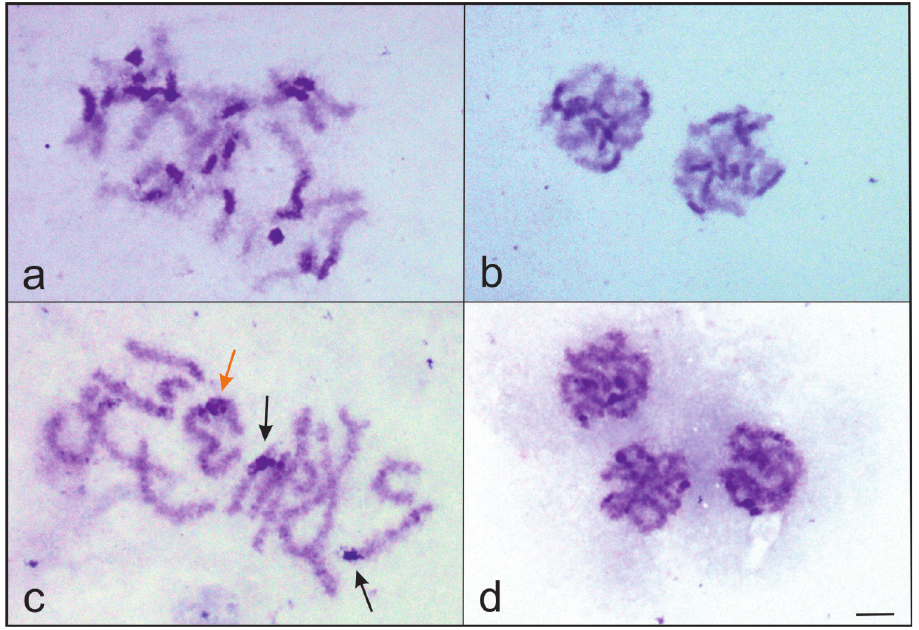
Figure 2. a–b N. bozdagus with dark heterochromatic blocks on all chromosomes. a leptotene–zygotene b pachytene c–d N. plebejus with two distinctive heterochromatic blocks (black arrows); c leptotene–zy- gotene d pachytene. Orange arrow indicates Xy sex bivalent, Bar = 5 p